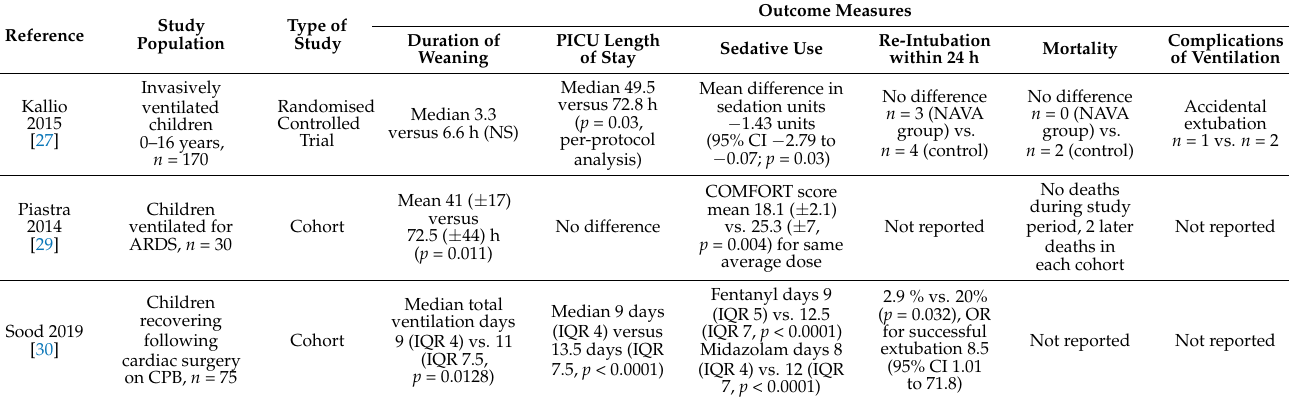
Table 1. Included studies of weaning in NAVA versus conventional modes of ventilation in